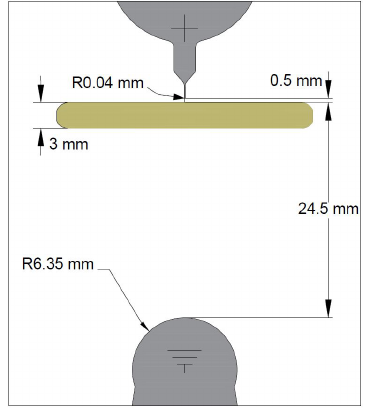
Figure 2. Solid dielectric immersed